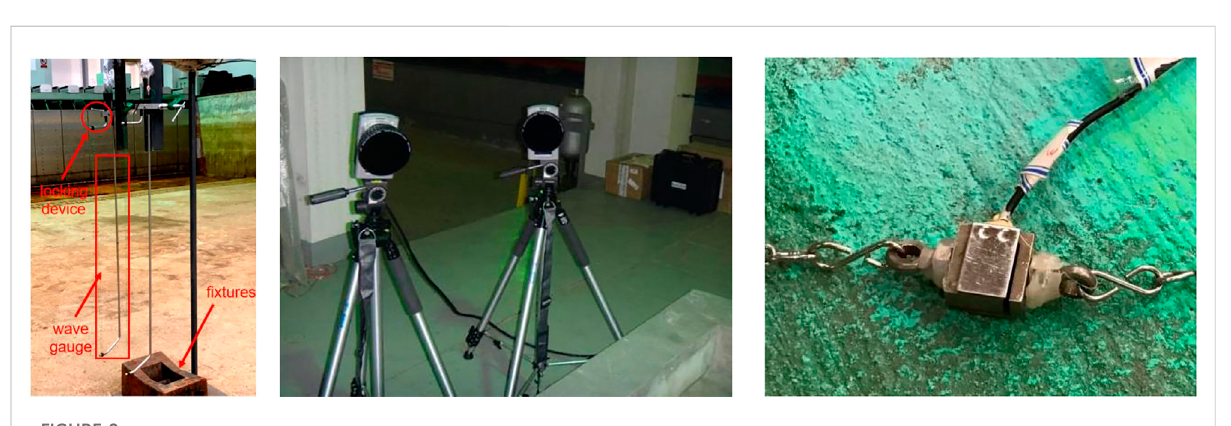
FIGURE 8 Capacitive wave gauge. 6 D.O.F. monitor. Tension